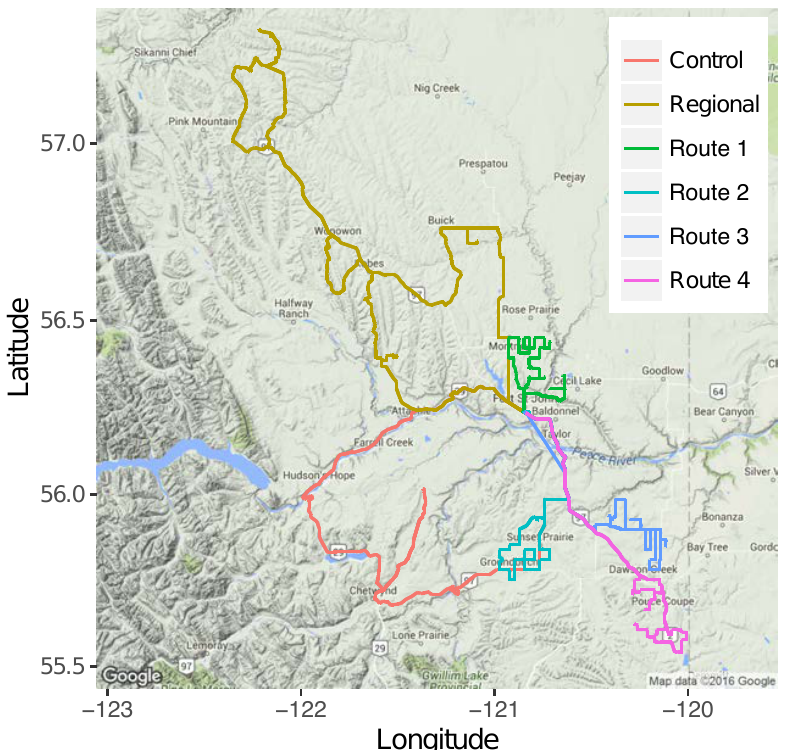
Figure 1. Map of mobile survey routes. Each route was surveyed six times in August–September 2015. The regional route and routes 2–4 dissected unconventional natural gas developments. Route 1 surveyed conventional oil. The control route was located in an area with a comparatively small amount of oil and gas development, although it passed by some infrastructure on route 2 upon returning to the Fort St. John area due to lack of accessible roads in the area. Table 1. Survey statistics by route. Route locations are shown in Fig. 1. Routes Control Regional 1 All Route length (km) 370 Number of repeat surveys Totalkm surveyed